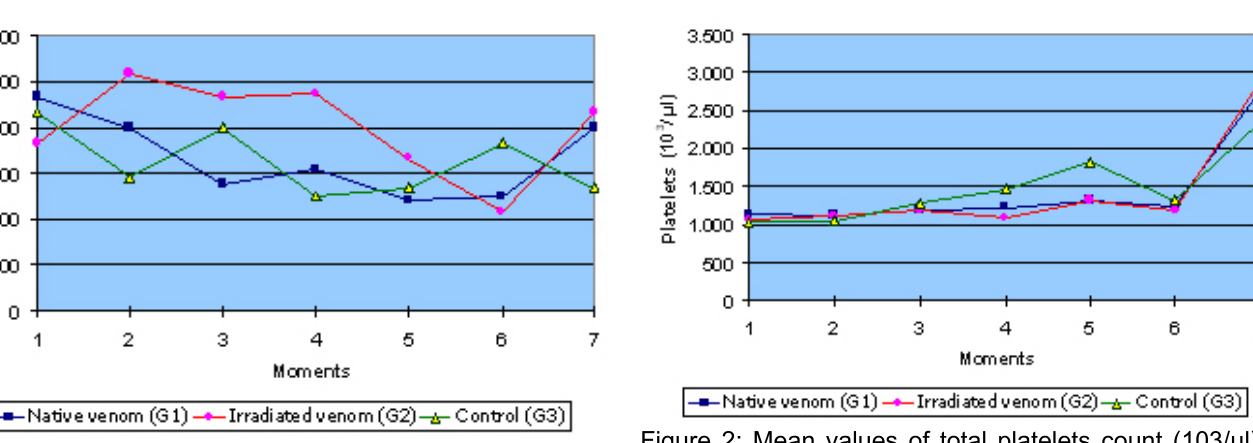
Figure 1: Mean values of fibrinogen dosage (mg/dl) in ovine groups inoculated with natural (G1) and 60 Co-irradiated (G2) C.d.t. venom, and control group (G3), at different moments.